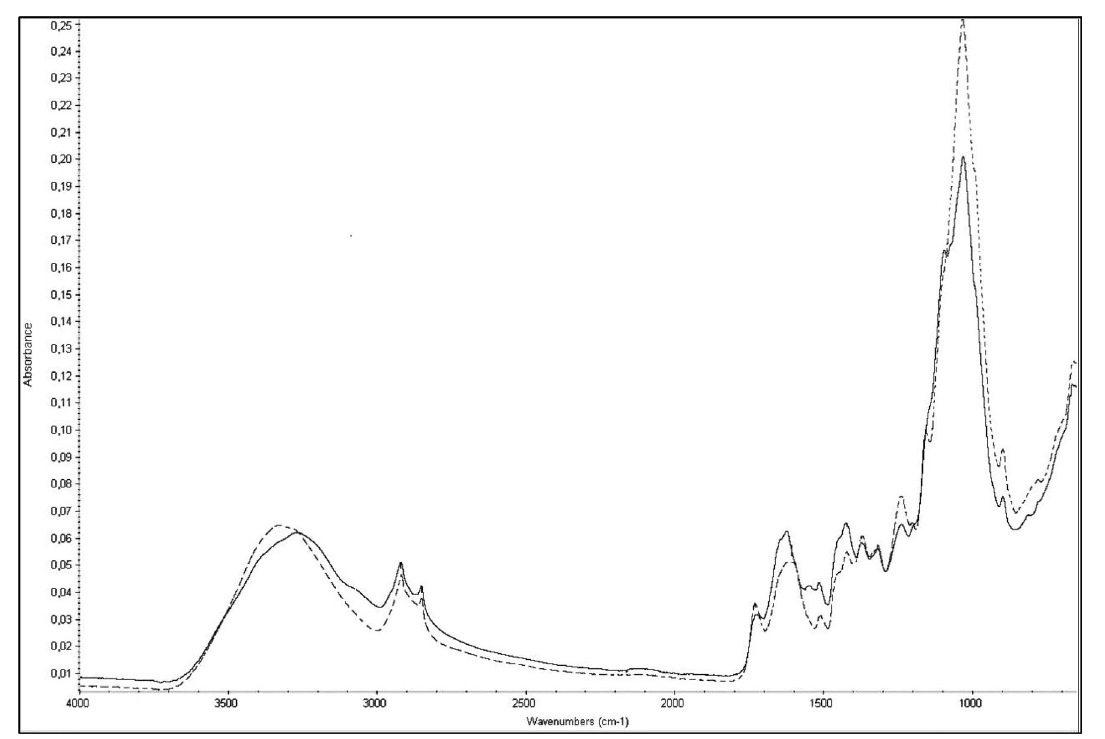
Fig. 4 FTIR spectra of untreated (dashed line), and fermented wheat straw (continuous line) Table 6 Characteristics and variations in FTIR spectra of untreated and fermented wheat